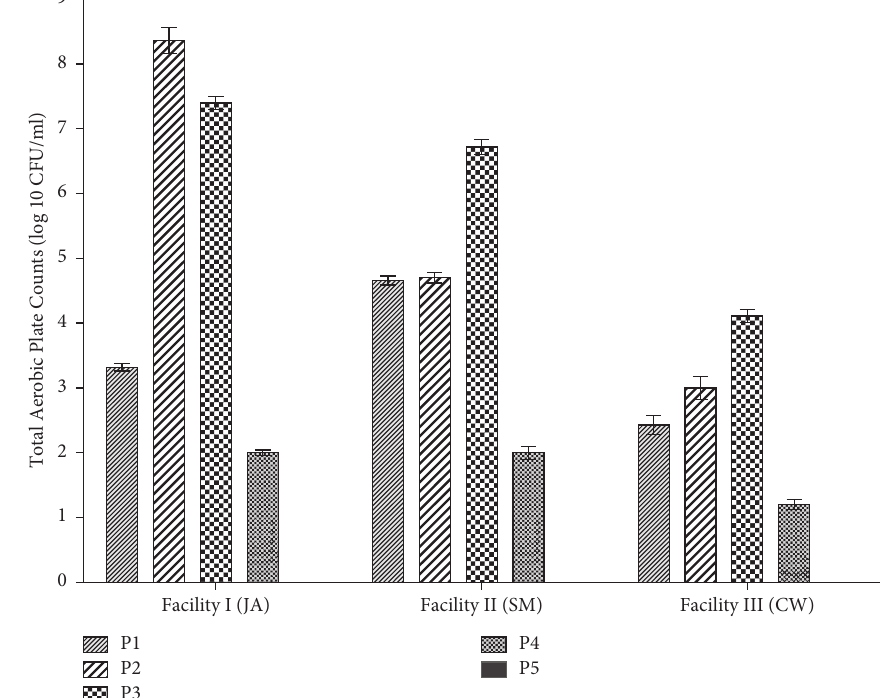
Figure 2: The total aerobic plate count among sampling points at each processing facility. Pre-identified five different sampling points are , P ,P , P , and P , respectively; Three studied processing facilities are denoted as JA, SM, and CW. Error bars indicate SD. denoted as P 1 2 3 4 5